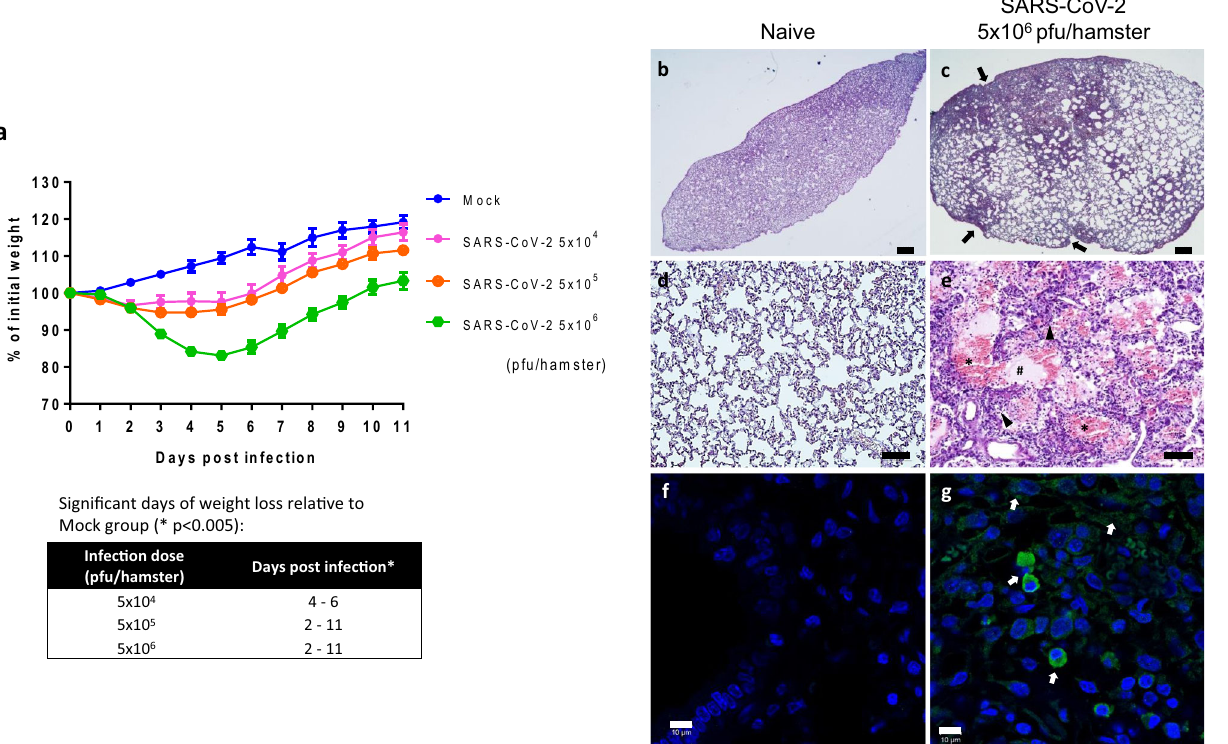
Fig. 4 Establishment of a golden Syrian hamster SARS-CoV-2 model. a Body weight changes of hamsters infected with 5 × 10 4 ( n = 8), 5 × 10 5 ( n = 8), or 5 × 10 6 ( n = 8) pfu/hamster of SARS-CoV-2, compared to mock-infected hamsters ( n = 4). Table shows days of signi fi cant differences, relative to mock infection. Statistical analysis was performed using one unpaired t -test per row, with correction for multiple comparisons using the Holm – Sidak method, p < 0.005. b – g Lungs were isolated and processed for paraf fi n embedding from naive hamsters (left panels) or SARS-CoV-2-infected hamsters (right panels, 5 × 10 6 pfu/hamster) at 7 dpi. Sections (5 µ m) were taken for H&E staining ( b – e ) and SARS-CoV-2 immunolabeling ( f , g , nuclei-blue, SARS-CoV-2-green). b – e : scale bar = 100 µ m; f , g : scale bar = 10 µ m. Black arrows indicate patches of focal in fl ammation, pleural invagination, and alveolar collapse. An asterisk (*) indicates hemorrhagic areas. A hash symbol indicates edema and protein-rich exudates. Black arrow heads indicate pulmonary mononuclear cells. White arrows indicate SARS-CoV-2 positive immunolabeling. Naive group: n = 4, SARS-CoV-2 5 × 10 6 7 dpi group: n = 1. Source data are provided as a Source Data fi